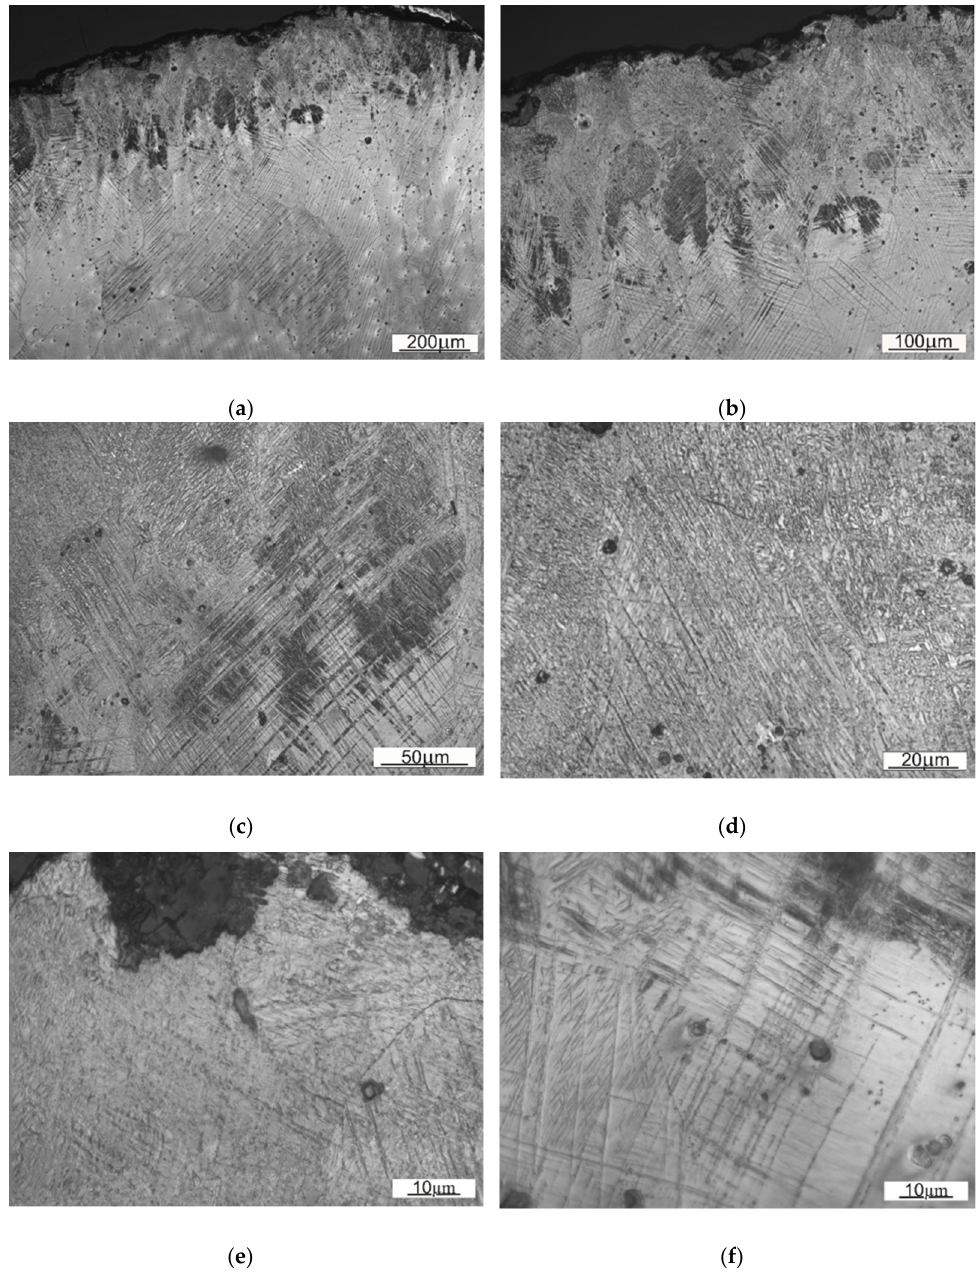
Figure 10. A view on the microstructure of the region located nearby the working surface of the sample SS1: ( a ) 10x magnification, ( b ) 20x magnification, ( c ) 50x magnification, ( d ) 100x magnification, ( e ) 150x magnification, ( f ) 150x magnification.